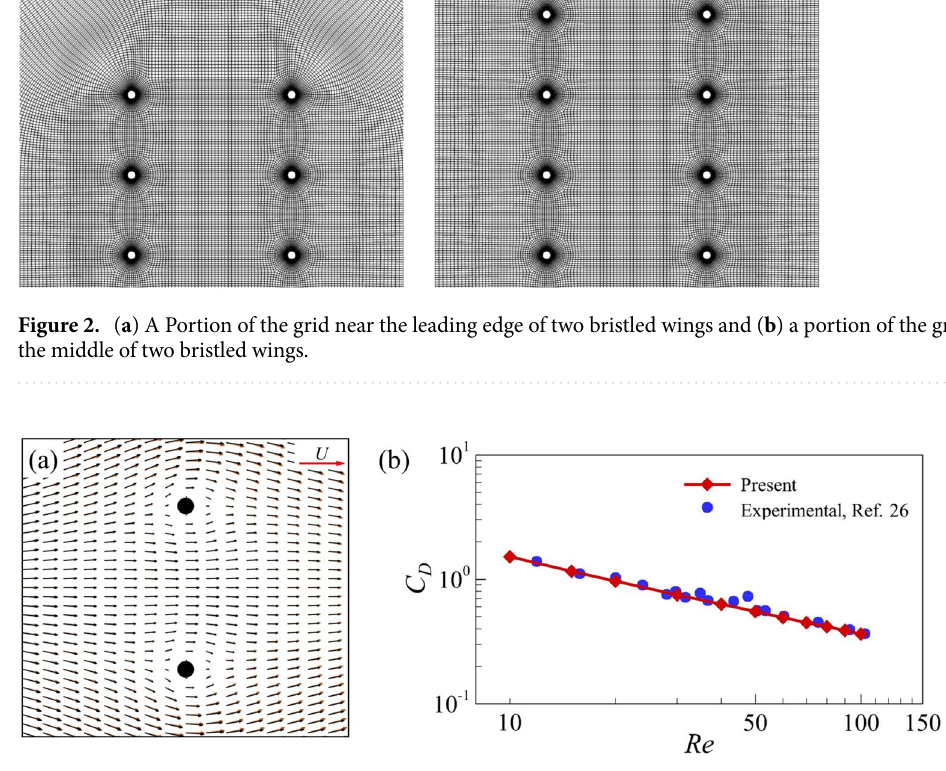
Figure 3. ( a ) Comparison of the velocity vector distribution of two equal cylinders obtained by the present method (black arrow) with the result derived from analytical solution (red arrow). ( b ) Comparison of the drag coefficient of a single flat-plate wing at zero angle of attack obtained by the present method with the experimental